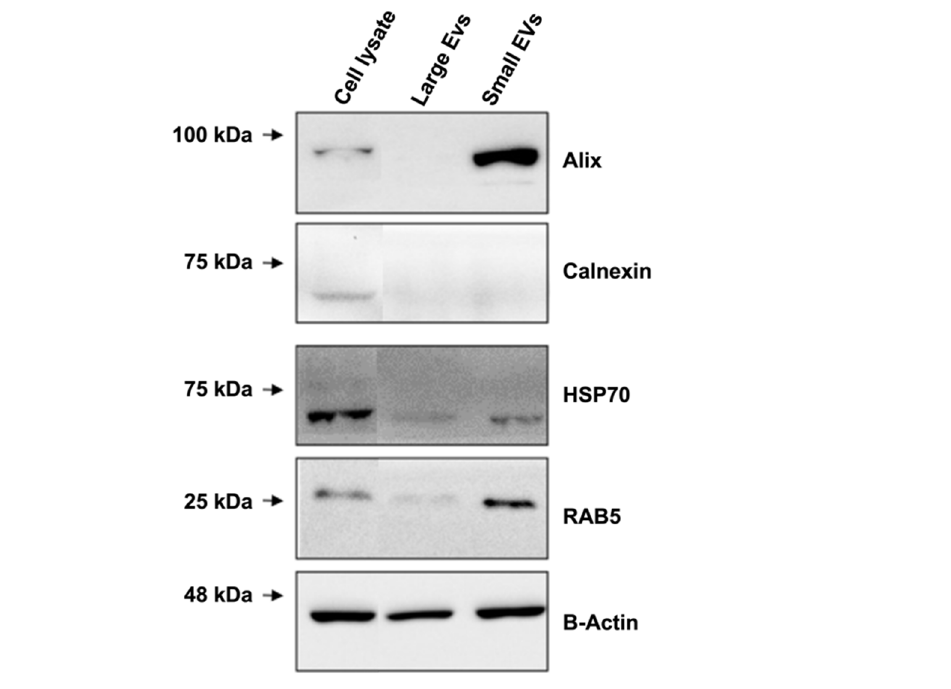
Figure 3. Western blot analysis of large extracellular vesicles (EVs), small EVs, and total lysates from C2C12 cell lines (10 µg of protein per lane) to detect the expression of Alix, calnexin, HSP70, and RAB5. Β -Actin was used as a loading control.